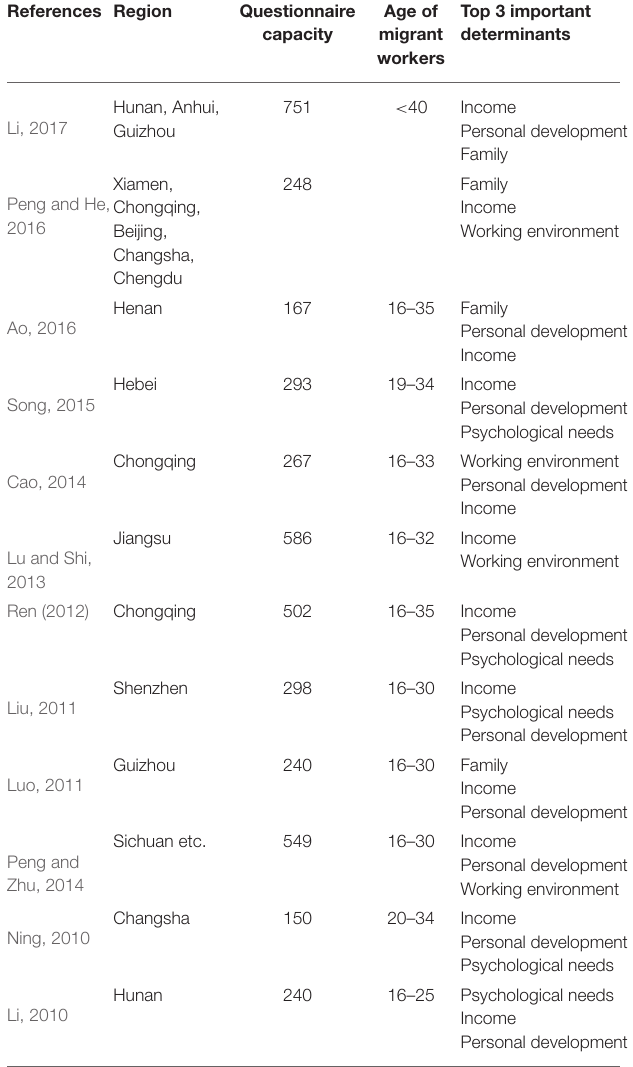
TABLE 1 | Existing research of Chinese migrant workers.